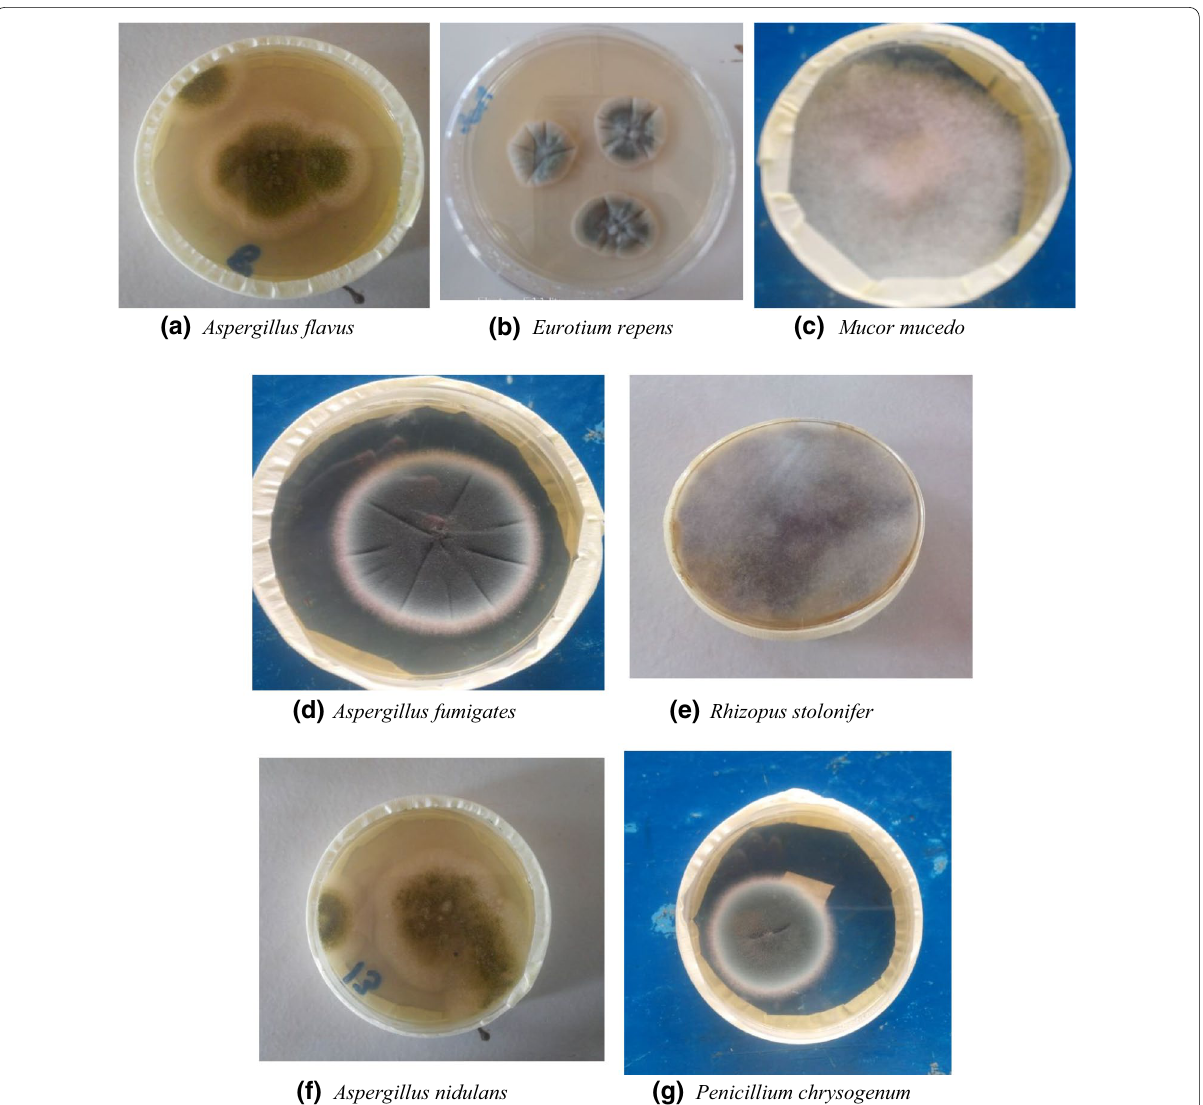
Fig. 2 a Aspergillus flavus , b Eurotium repens , c Mucor mucedo , d Aspergillus fumigatus , e Rhizopus stolonifer , f Aspergillus nidulans , g Penicillium chrysogenum